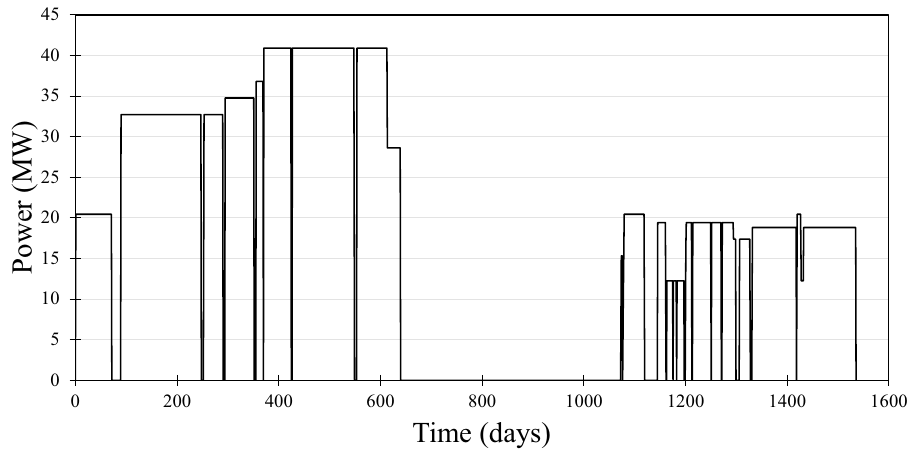
Figure 1. A simplified history of the power experienced by the fuel pellets in this study during the two irradiation periods of the reactor.